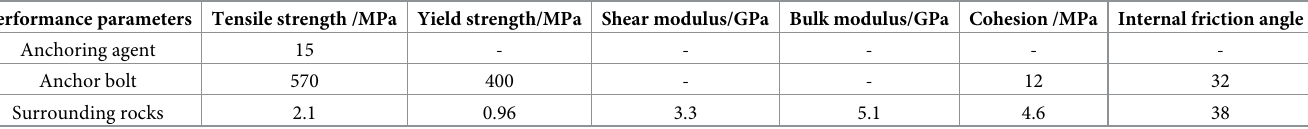
Table 2. Mechanical parameters of materials.